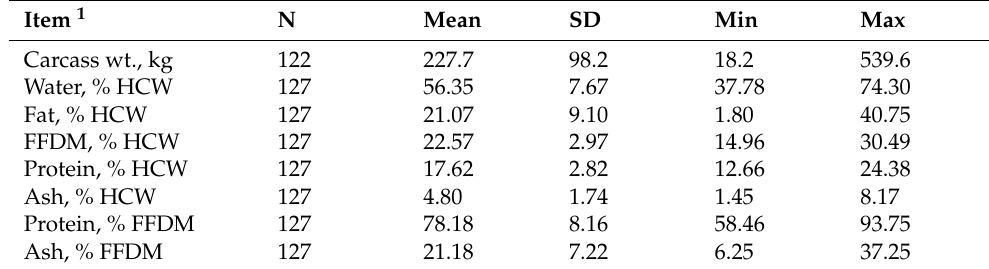
Table 8. Summary statistics of carcass chemical composition of cattle in the Carcass